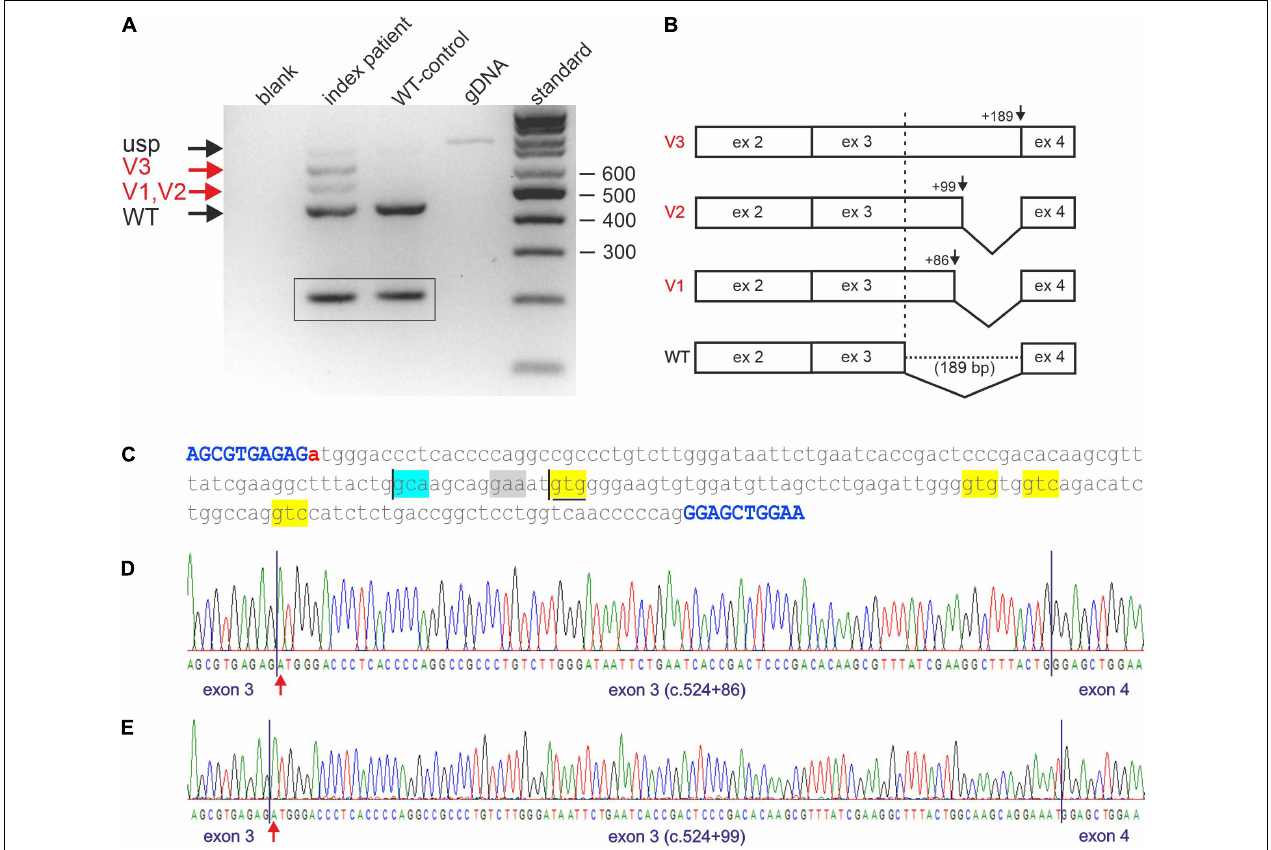
FIGURE 2 | Impaired STUB1 splicing. (A) Expression studies of processed STUB1 transcripts of the index patient (II-4) and a control. (blank) control without template, (index patient) reverse transcription polymerase chain reaction (RT-PCR) on RNA of the index patient, (WT-control) RT-PCR on RNA of the WT-control, (gDNA) genomic DNA, (standard) 100 bp size standard. Black arrows indicate the correctly processed exon 2–4 fragment of STUB1 (WT) and the weak, unspliced (usp) product. Red arrows indicate incorrect splicing in the index patient. Splice variants 1, and 2 (V1, V2) correspond to the cryptic splice sites, while splice variant 3 (V3) contains retained intron 3 of STUB1 . TBP -derived 210 bp control fragments for RNA integrity are shown in boxes. (B) Graphical overview of impaired splicing (V3-V1) caused by variant c.524+1G > A compared to the correctly spliced wild type (WT) allele. (C) Sequence of intron 3 of STUB1 (lower case) flanked by exons 3 and 4 (upper case, blue). Pathogenic variant c.524+1G > A is highlighted in red. The main cryptic splice site c.524+86 is boxed in blue. Predicted cryptic splice donor sites by Alternative Splice Site Predictor analysis are boxed in yellow, the predicted splice acceptor is boxed in gray. The ultra-rare used cryptic splice site c.524+99 is underlined. (D) Electropherogram of products using the cryptic splice site c.524+86. (E) Electropherogram of products using the ultra-rare cryptic splice site